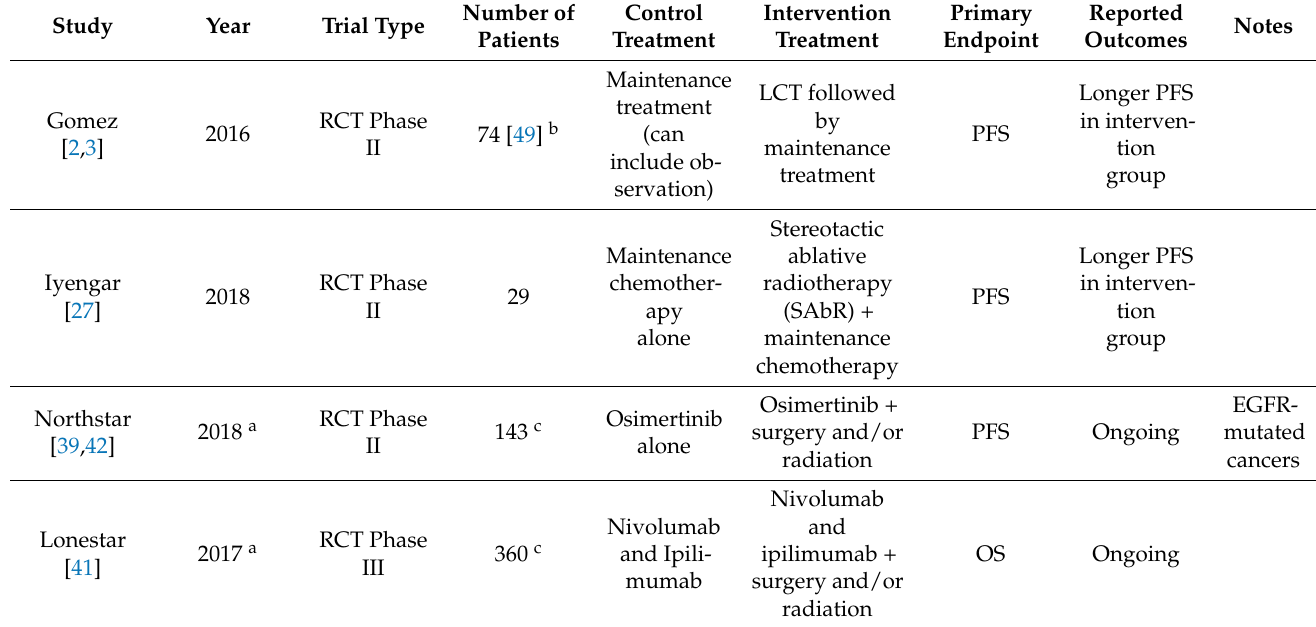
Table 2. Details of published and ongoing randomized trials of local consolidative therapy in patients with oligometastatic non-small cell lung